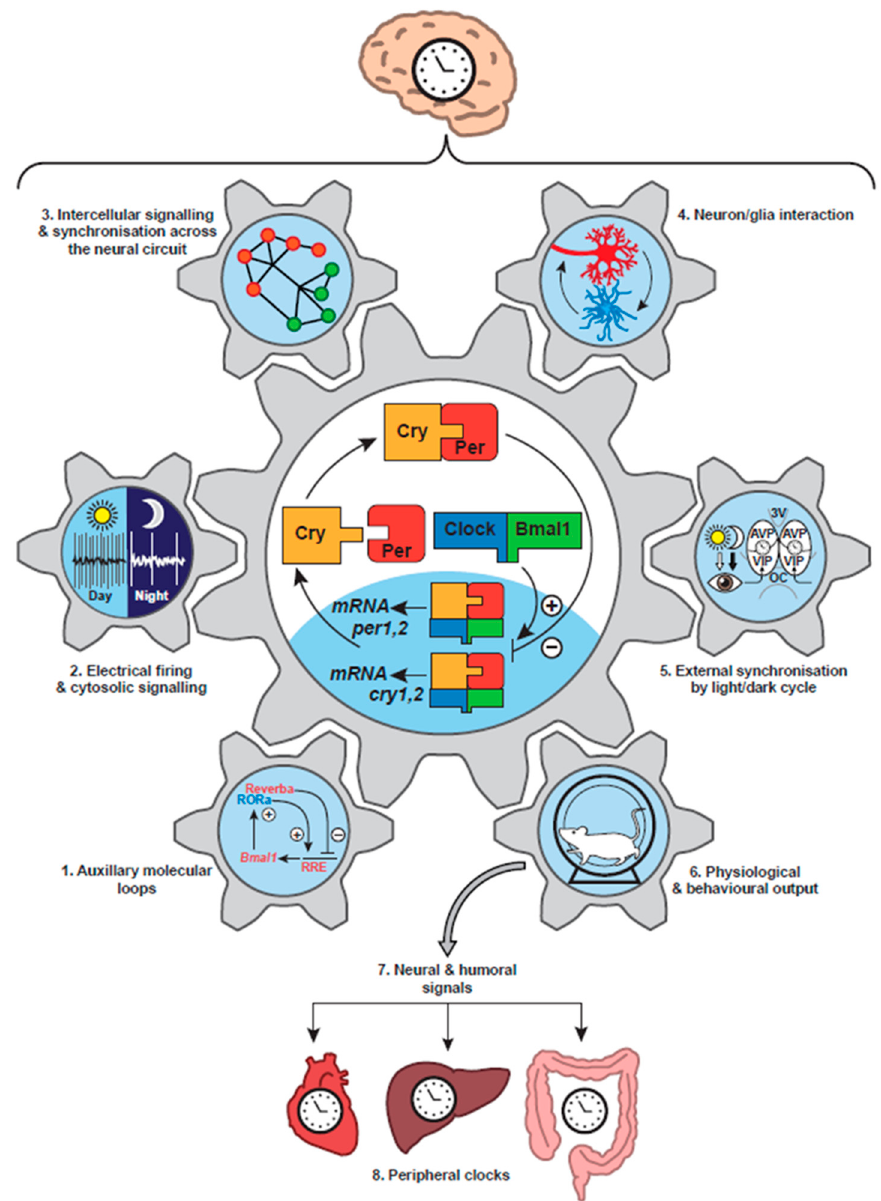
Figure 1. Schematic view of the mechanisms that direct circadian time-keeping in the suprachiasmatic nucleus. The suprachiasmatic nucleus (SCN) is the principal circadian pacemaker of the mammalian brain (upper panel) that ultimately orchestrates circadian metabolism and physiology by redirecting the activity of local, tissue-based circadian clocks (lowest panel). A characteristic feature of the SCN (central panel) is that outputs of the circadian timing system also operate as inputs to it. This recurrent activity, observed at all levels of organisation: molecular, cellular and whole-animal, confers on the SCN its markedly precise, high-amplitude and robust time-keeping. At the heart of the SCN time-keeper (central “cog wheel”) is the cell-autonomous core transcriptional/post-translational feedback loop (TTFL), in which with the negative factors Per associate with Cry to inhibit their own Clock/Bmal1-driven transcription. ( 1 ) This core oscillation is further stabilised by auxiliary intra-cellular molecular feedback loops, whereby TTFL-driven circadian expression of Rev-erb and Rora feeds back to control the transcription of Bmal1. ( 2 ) By its control of downstream clock-controlled output genes, the TTFL of the SCN drives circadian cycles of cell-autonomous electrical firing and associated cytosolic signalling, including daily rhythms of cAMP and [Ca 2+ ]i, These in turn feedback into the TTFL via the calcium/cAMP-responsive elements of Per genes, adding further stability to the cell-autonomous SCN oscillator. ( 3 ) The cell-autonomous circadian rhythms are synchronised across the SCN circuit by inter-cellular